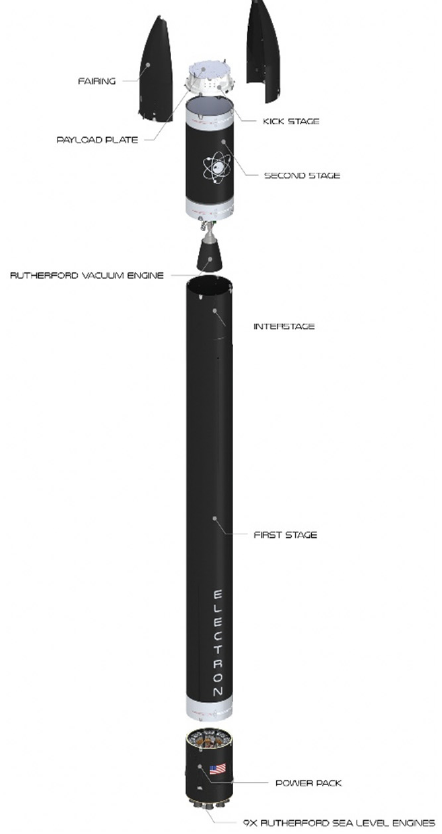
Figure 3. Electron small launch vehicle.